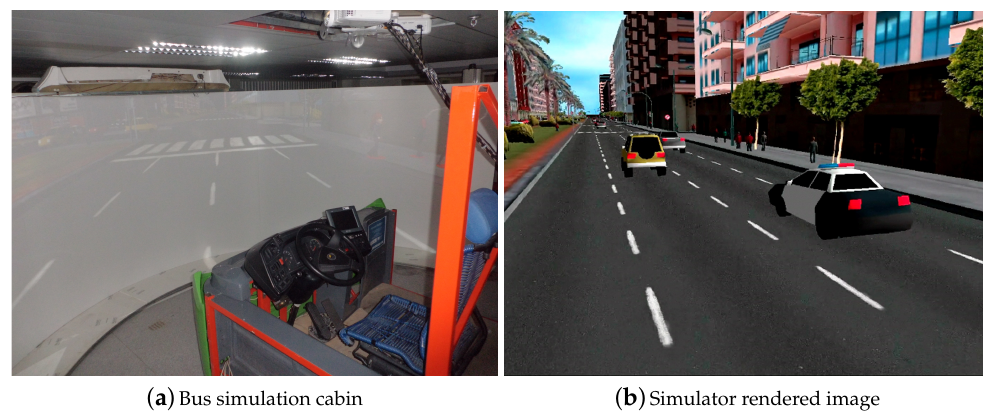
Figure 1. Bus simulation cabin and urban simulated